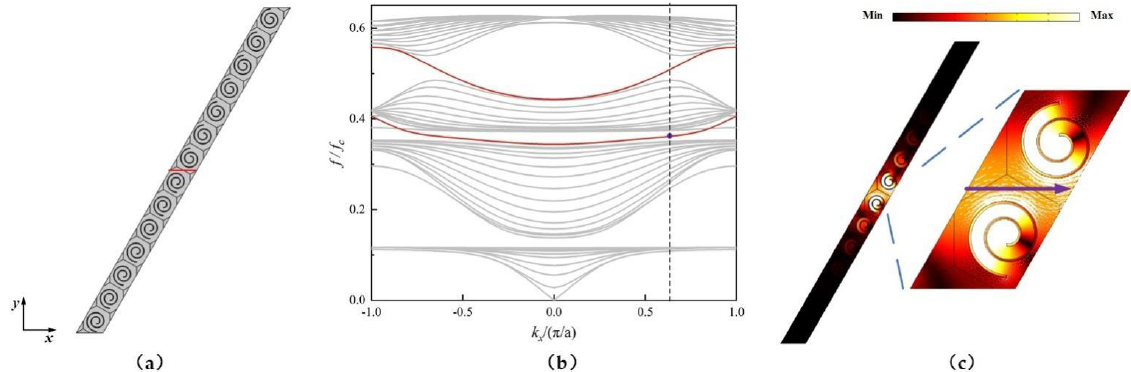
Figure 7. ( a ) The ribbon-shaped superlattice in 14a × a composed of left-handed and right-handed spiral units. ( b ) The projected band structure of the superlattice in the k x direction; the edge state and bulk state are represented by the red curve and gray curve, respectively. ( c ) The pressure and intensity field on the interface for the edge states of the second band gap with k x = 0.6π/ a . The purple arrow represents the direction of the energy flow.